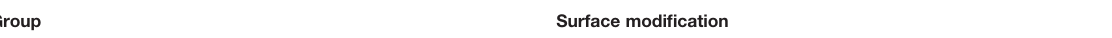
TABLE 1 | List of surface modi fi cation conditions of commercially pure titanium disks. Titanium Group